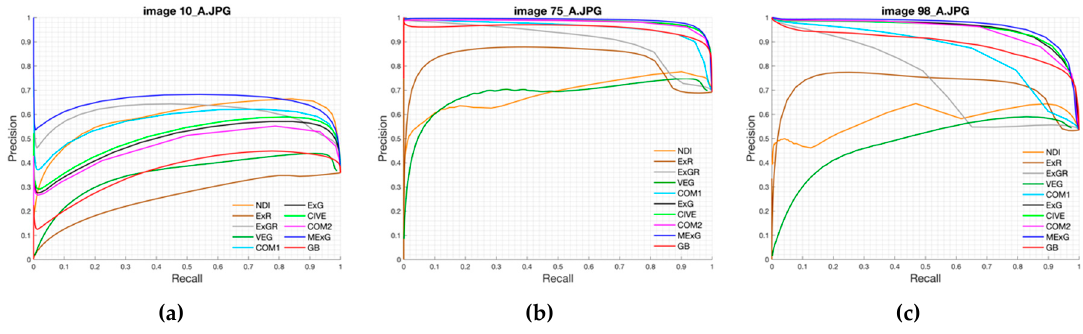
Figure 4. Images of 2000 × 1500 pixels used to evaluate the performance of colour vegetation indices: ( a ) image 10_A; ( b ) image 75_A and ( c ) image 98_A.